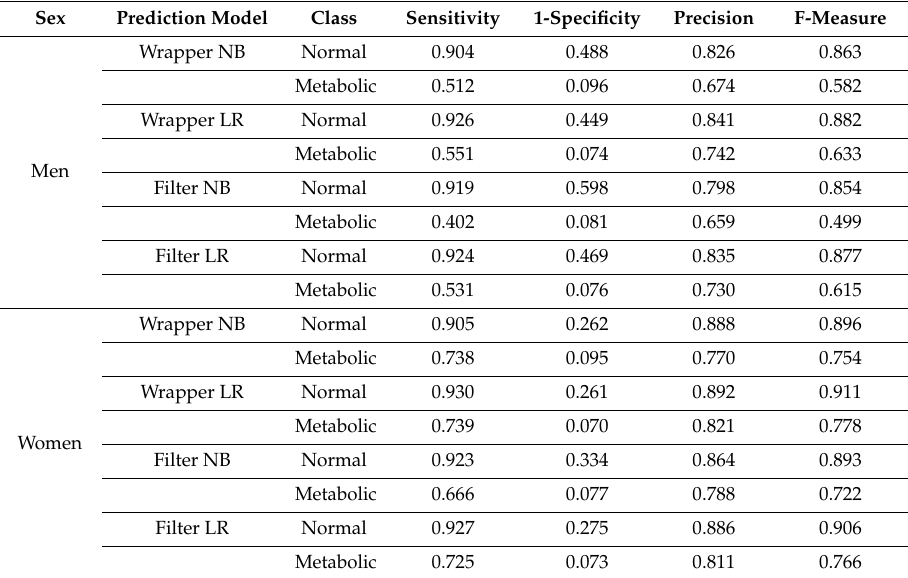
Table 6. Predictive power analysis of the four models in men and